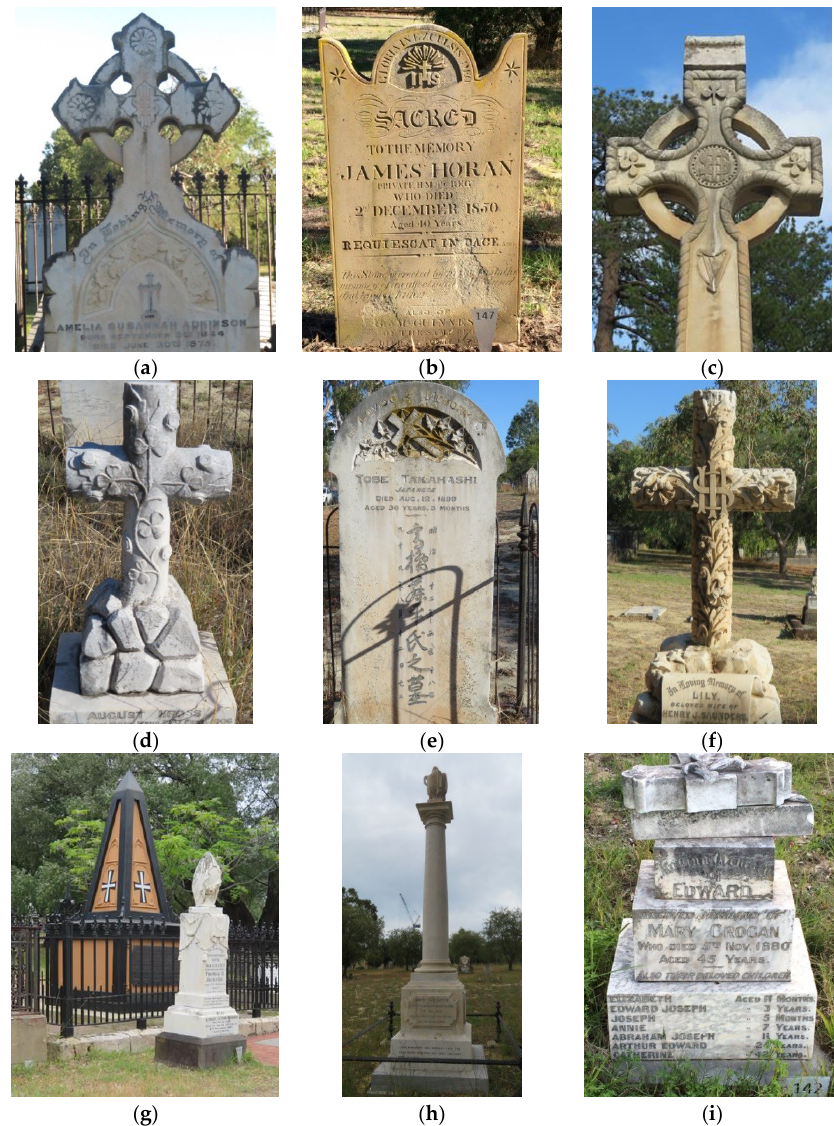
Figure 2. Examples of monuments showing identity: ( a ) Anglican/Amelia Adkinson with elaborate open Celtic cross and “IHS”; ( b ) R.Catholic/James Horan with sunrise “IHS”; ( c ) R.Catholic/Teresa Quinlan, Celtic cross, “IHS”, shamrock, lychgate top, pious Irish verse, shamrocks, and Irish harp; ( d ) Wesleyan/August Kross with shamrocks on rustic Latin cross and rocks; ( e ) Wesleyan/Tobe Takahashi, Japanese calligraphy and English epitaph; ( f ) Anglican/Lily Saunders with “IHS”, madonna lilies on rustic cross, and rocks; ( g ) Anglican/Explorers’ obelisk; ( h ) Presb’n/David Shearer, column and urn; ( i ) R.Catholic/Crogen family calvary cross. Photographs by S. Hayward (2017).